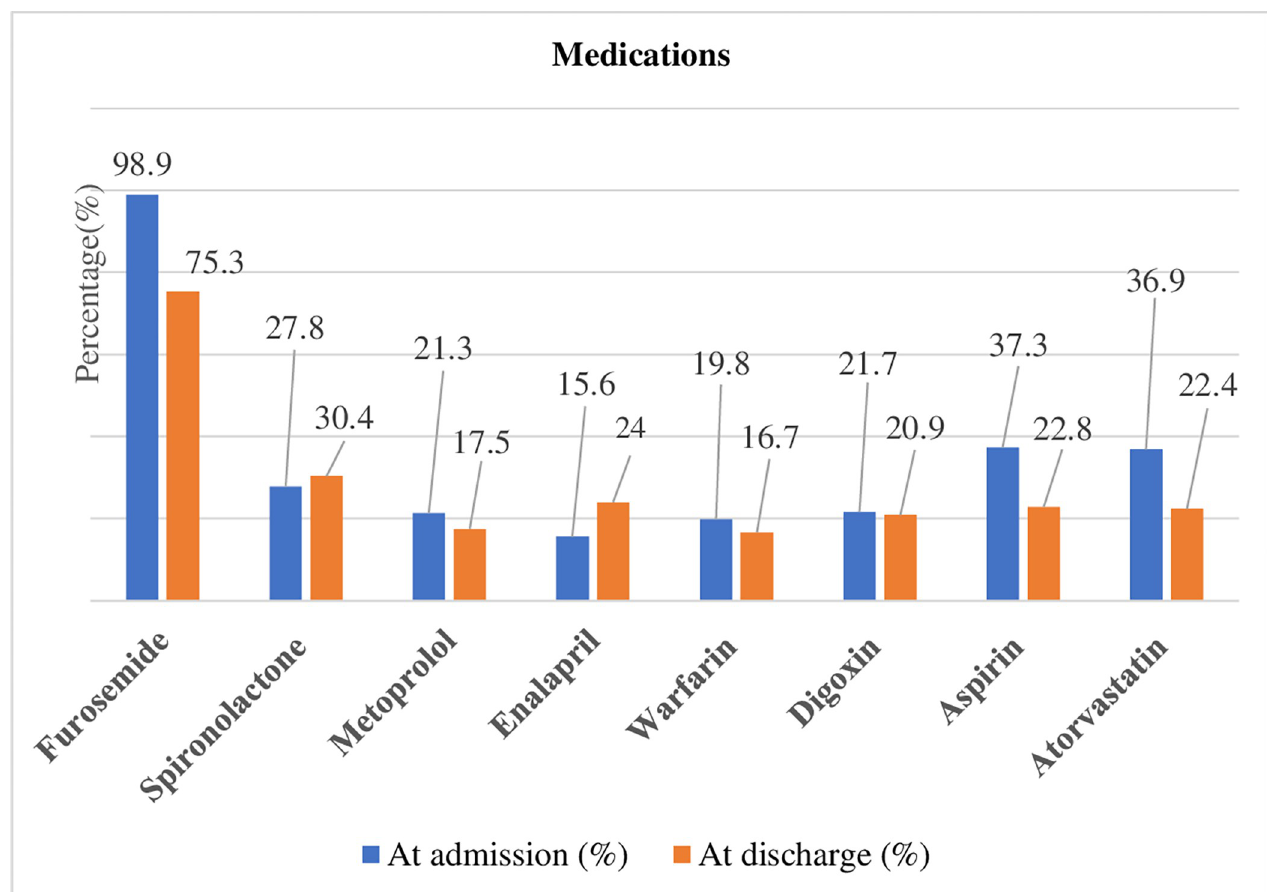
Fig 3. Medications received by AHF patients admitted at UOGCSH medical ward, 2020 (N = 263).